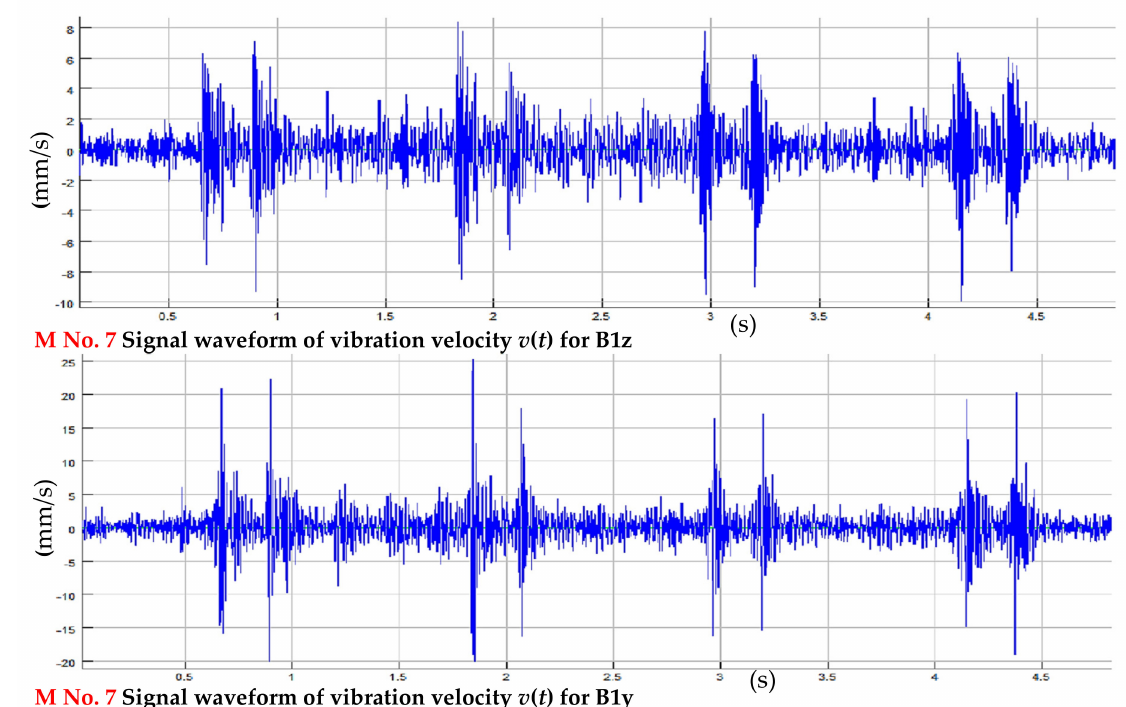
Figure 11. Total signal waveform of vibration velocity v ( t